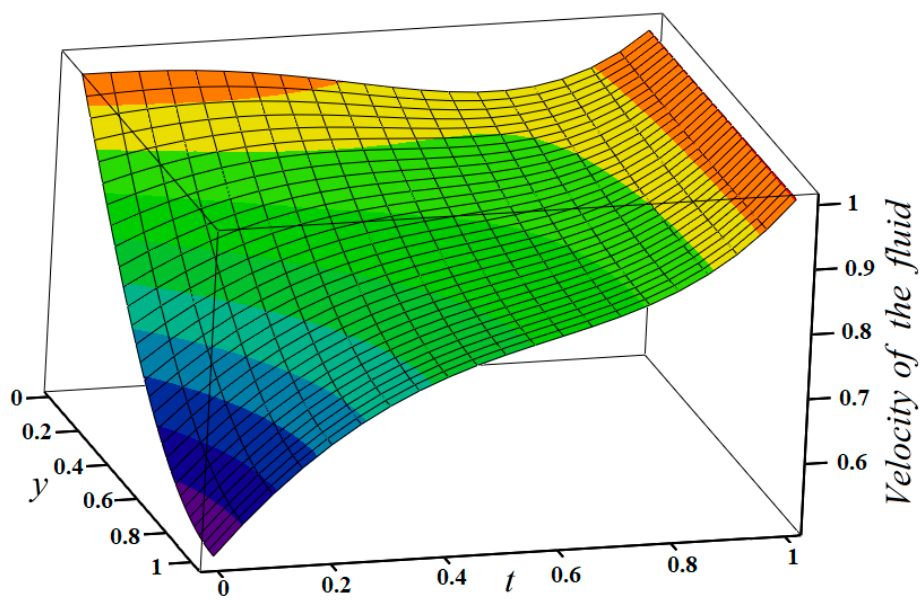
Figure 11. 3D plot of fluid velocity.